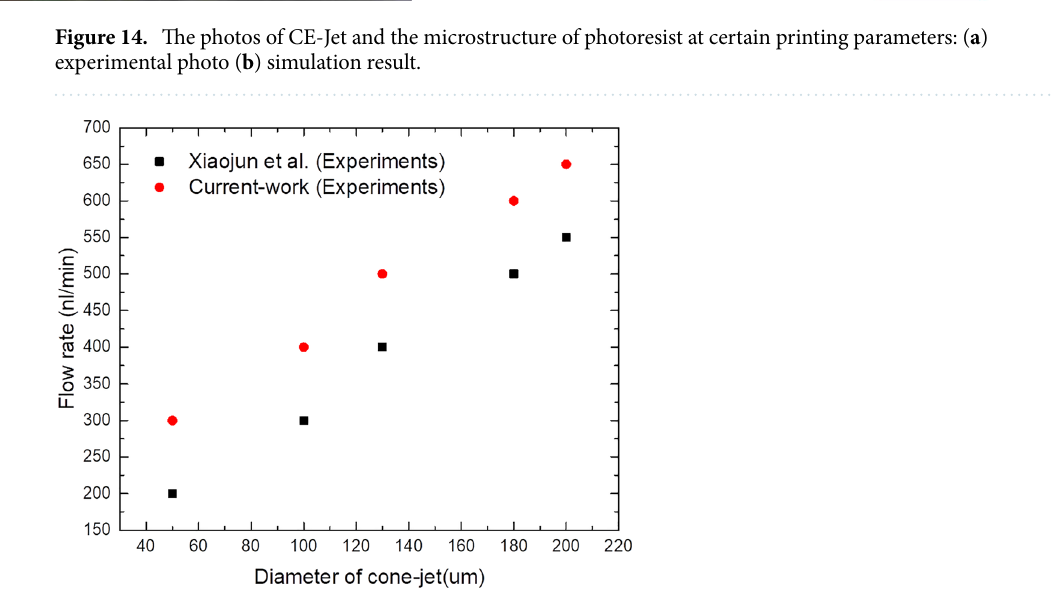
Figure 15. The CE-Jet diameter as a function of the flow rate for inner PZT